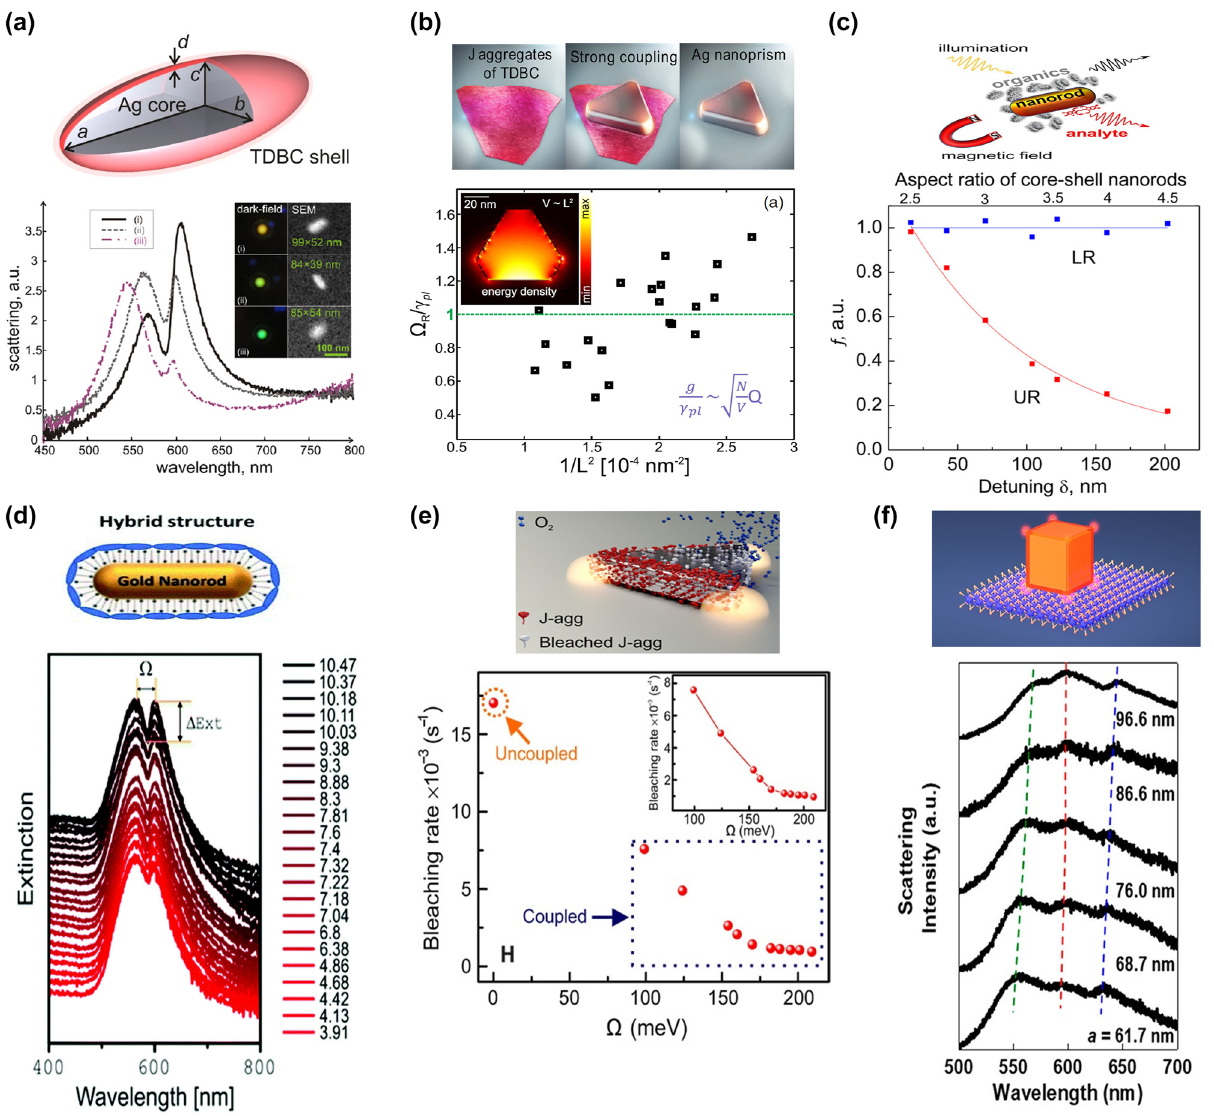
Figure 3: Physical and chemical characteristics of plexcitonic systems. (a) Scattering spectra of three individual plexcitonic systems with Ag nanorod and TDBC J-aggregate shell using the dark field. The inset contains SEM and dark-field images of the corresponding plexcitonic ∕ 𝛾 by the inverse function of geometric volume. The inset images are the energy density distribution of system. (b) Distribution of Ω R pl nanostructure. (c) The ratio spectra of normalized magnetic circular dichroism (MCD) signal hybrid nanorod/J-aggregates plexcitonic system and bare core nanorod. This spectrum shows the magneto-optical activity of upper resonance (red) and lower resonance (blue) for detuning (corresponding aspect ratio of nanorods). (d) Extinction spectra for a Au nanosphere and J-aggregate hybrid nanosystem in terms of PH value. (e) Bleaching rate of uncoupled J-aggregates and plexcitonic system with Ag nanoprisms and J-aggregates coupling. (f) Scattering spectra in which diexcitonic strong coupling is observed through the hybrid system with Au nanocubes and two exciton . (a) Ref. [44] © 2013 the author(s). (b) Ref. [40] © 2015 American physical society. (c) Ref. [111] © 2017 material J-aggregates and WS 2 American chemical society. (d) Ref. [124] © 2020 the royal society of chemistry. (e) Ref. [105] © 2018 the author(s). (f) Ref. [108] © 2021 the